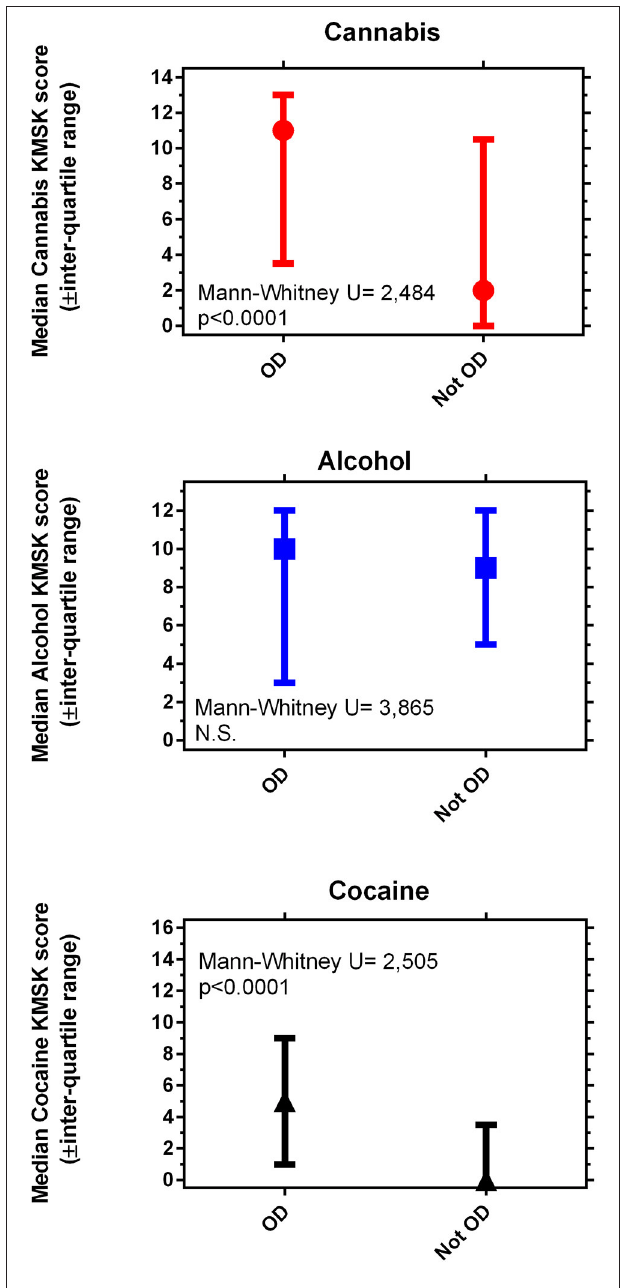
FIGURE 1 | Maximal self-exposure (KMSK scores) to non-medical cannabis (A) , alcohol (B), and cocaine (C) , upper, middle and lower panels, respectively, in volunteers with and without opioid dependence diagnoses (“OD” and “not OD,” respectively). The “not OD” group is the combination of volunteers with drug diagnoses except OD, and normal volunteers. The data represent two groups of n = 89 each, after the propensity score matching procedure (see Table 5 ).